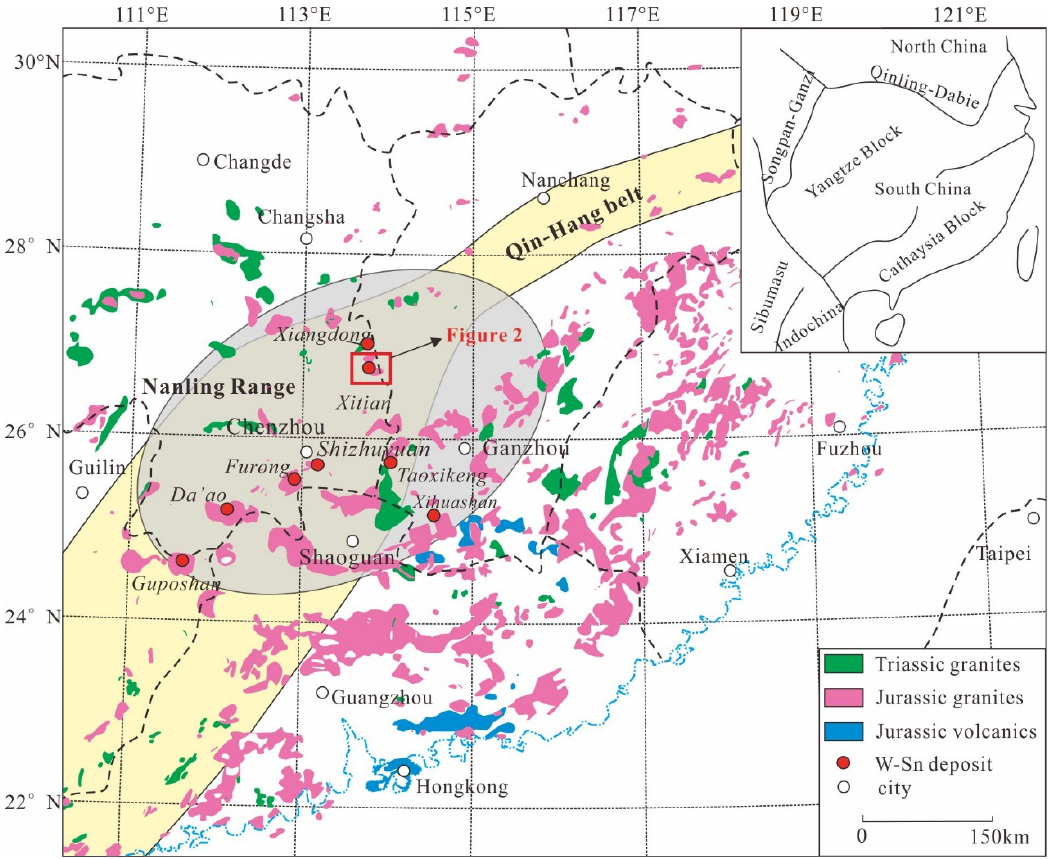
Figure 1. Geological sketch map of the South China Block showing the distribution of Mesozoic granite-volcanic rocks. The locations of granites and volcanics refer to [28]. The Xitian deposit also belongs to the Qin-Hang belt, an economic ore belt in South China [3,23]. It is a Neoproterozoic suture belt result from the collisions of the Yangtze Block and the Cathaysia Block, along the Jiangshan-Shaoxing fault [24,28]. Numerous Middle to Late Jurassic (171–150 Ma) calc-alkaline granitoids rocks and related Cu-Au-Mo-Pb-Zn-W-Sn deposits are distributed along the Qin-Hang belt in response to the Jurassic Paleo-Pacific Plate subduction [29,30]. Because of the superimposed influence of multistage tectonmagmatic events, the source of magma associated with polymetallic deposits remains highly